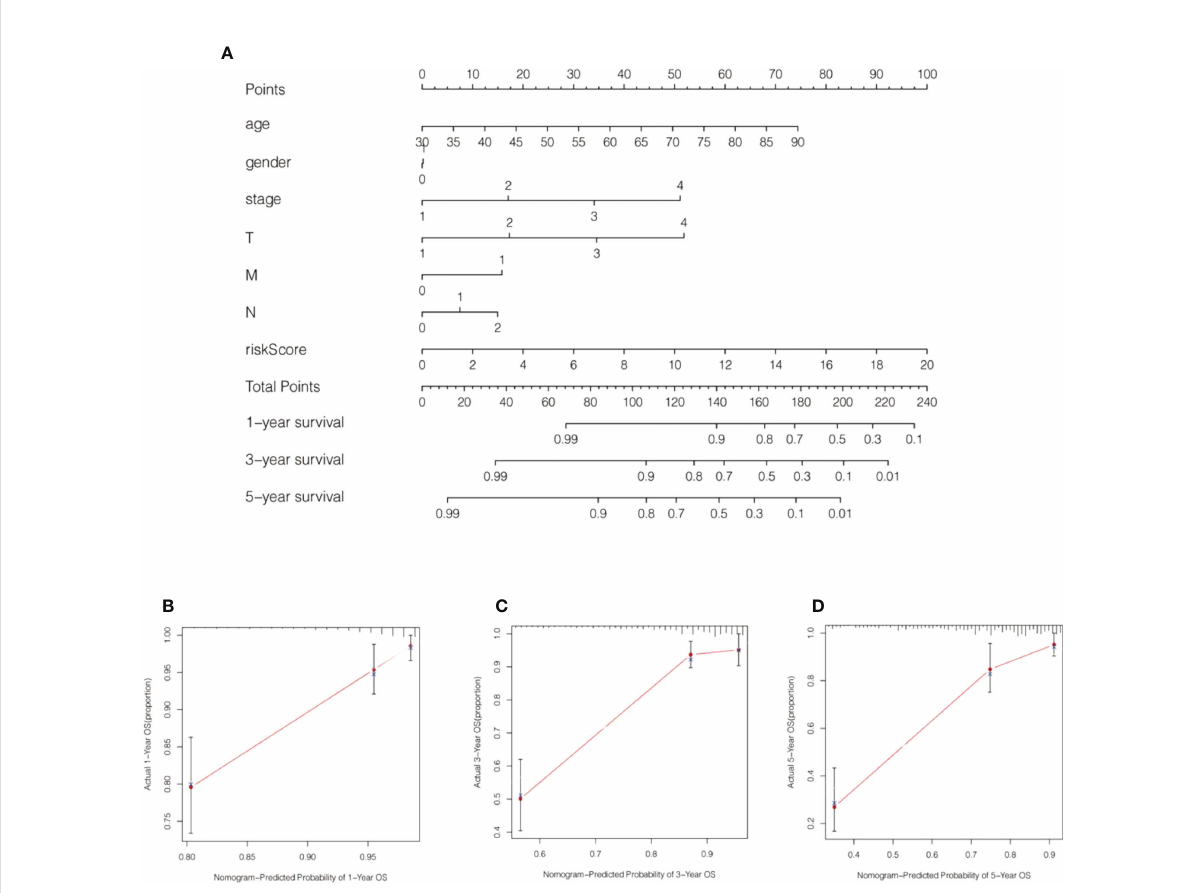
FIGURE 8 A nomogram was generated by combining risk scores and clinical characteristics. (A) A nomogram forecasting 1-, 3-, and 5-year overall survival was constructed. (B – D) Calibration curves of the nomogram display the consistency between the predicted and 1-, 3-, and 5-year survival